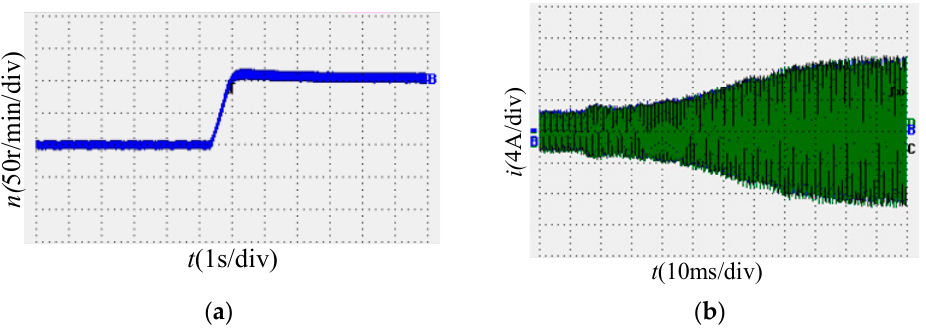
Figure 25. Waveform of the motor under sudden load: ( a ) speed waveform; ( b ) current waveform of the six-phase motor.